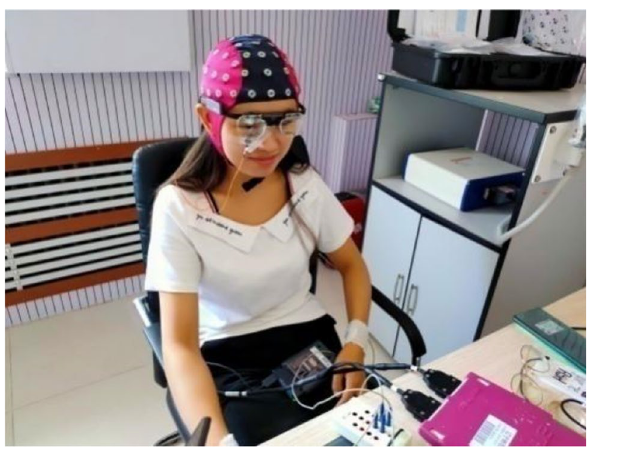
Figure 2. EEG data collection